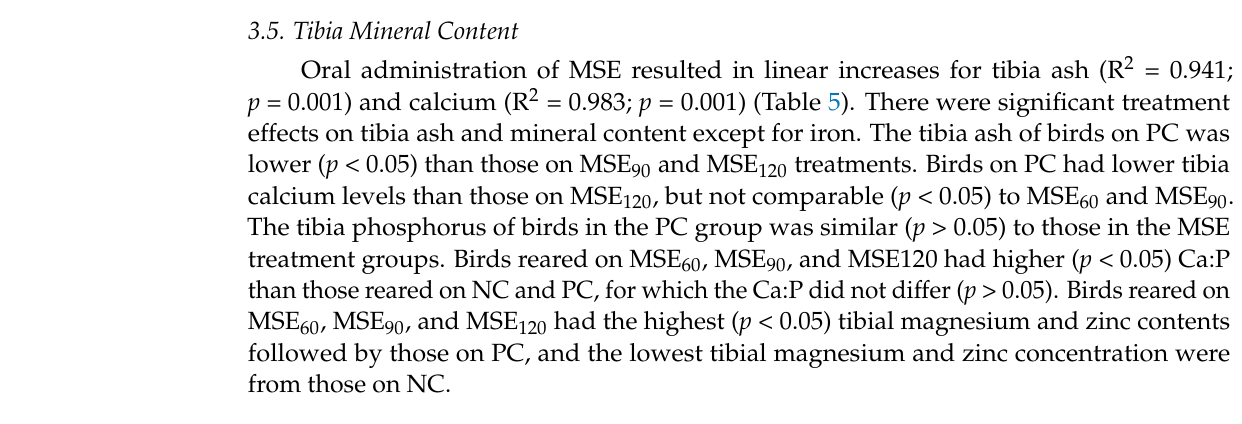
Table 5. Tibia ash and mineral content of six-week-old broiler chickens ( n = 125) orally administered with varying levels of moringa seed extract (MSE) in drinking